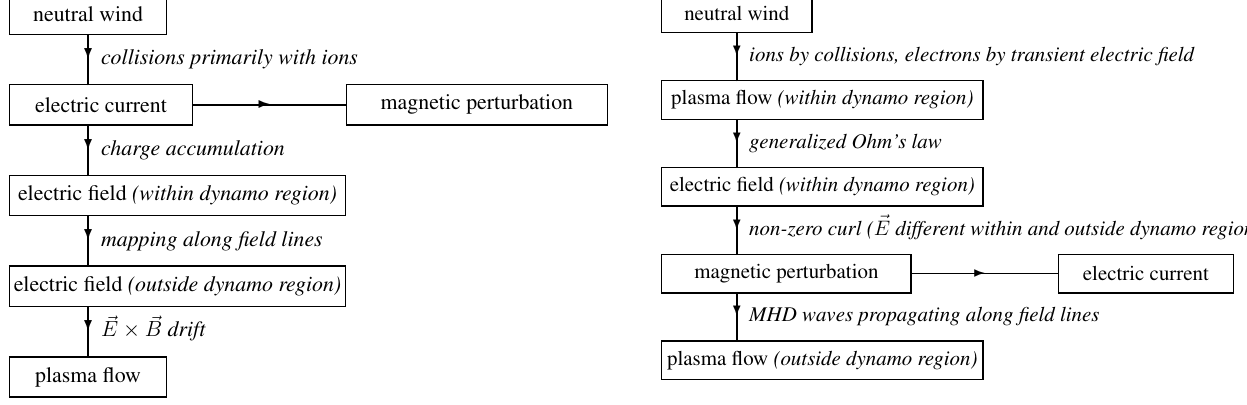
Fig. 3. Schematic diagram of how a neutral-wind dynamo devel- ops, as understood in the conventional approach.